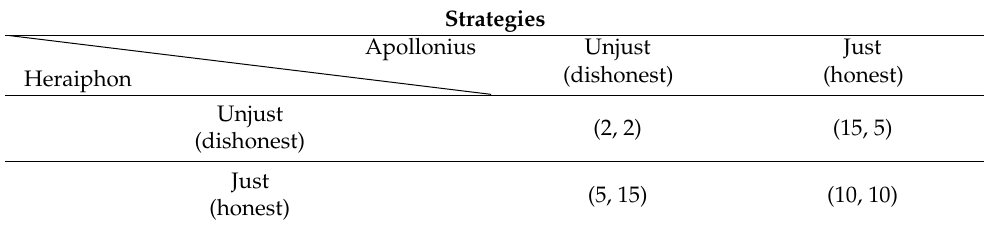
Table 1. First stage payoffs with players trusting each other—no need for state intervention.